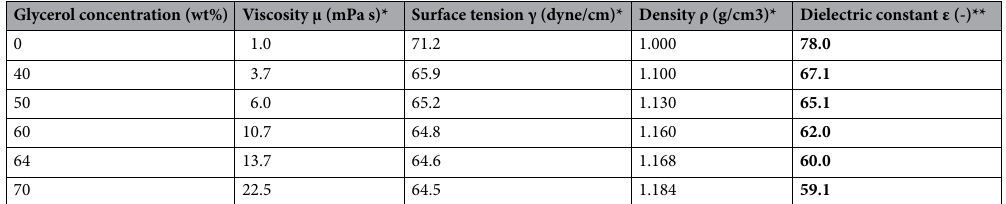
Table 2. Physical properties of the working fluids. *Hong et al. 29,30 , **Glycerine Producers’ Association. “Physical properties of glycerine and its solutions.” Glycerine Producers’ Association, 1963 31 . Significant values are in [bold].